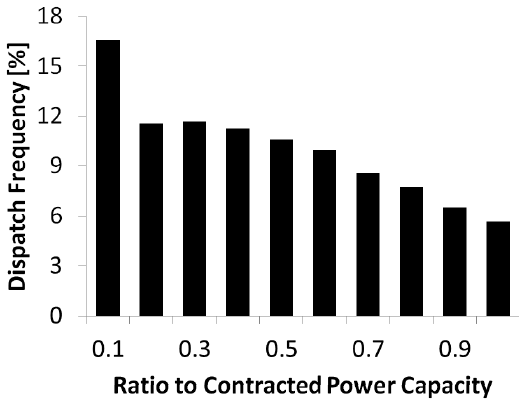
Figure 2. Distribution of dispatched power in 2010 from